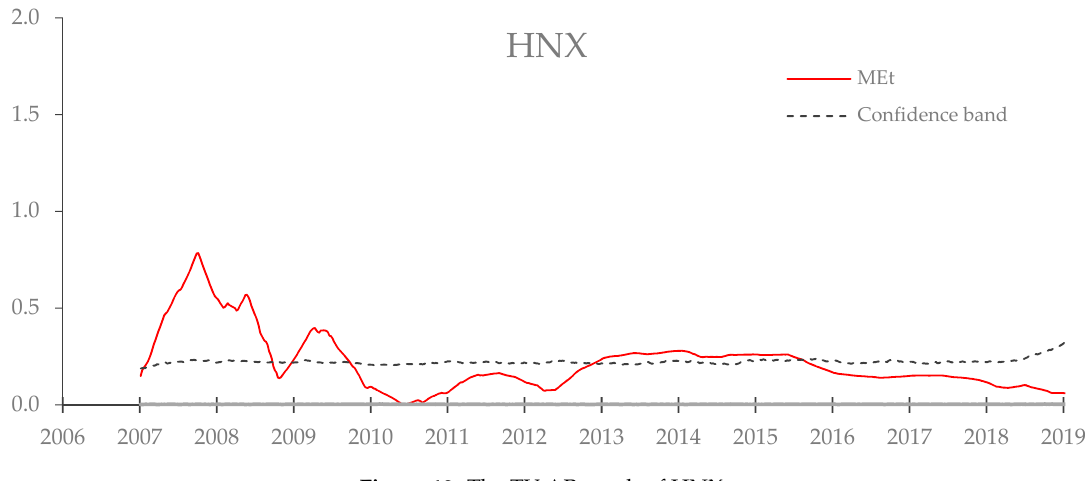
Figure 10. The TV-AR result of HNX.